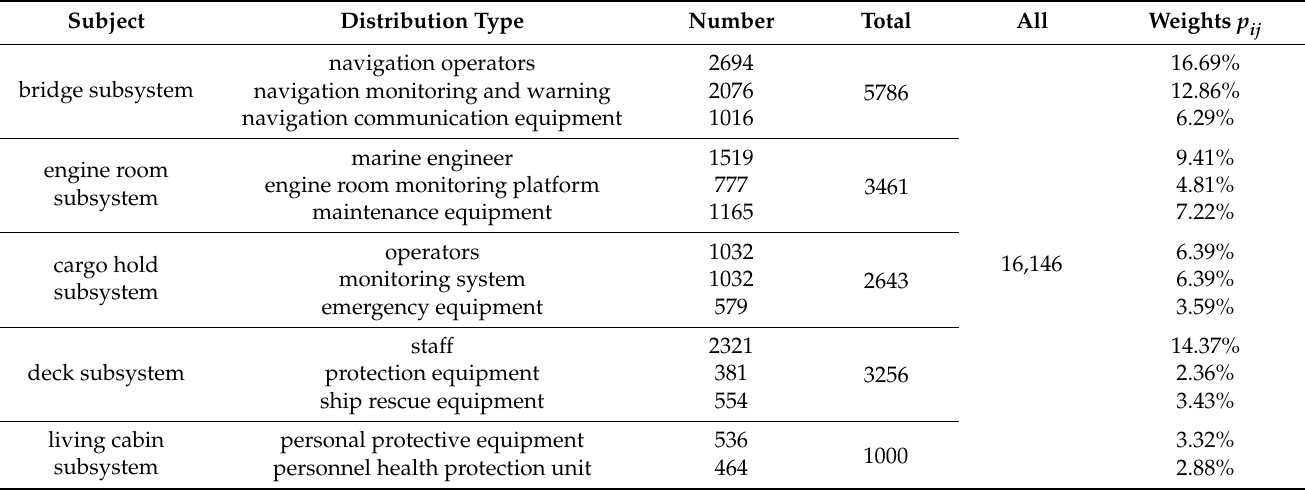
Table 12. Traditional accident statistical data of the IHS database in 2011–2021.